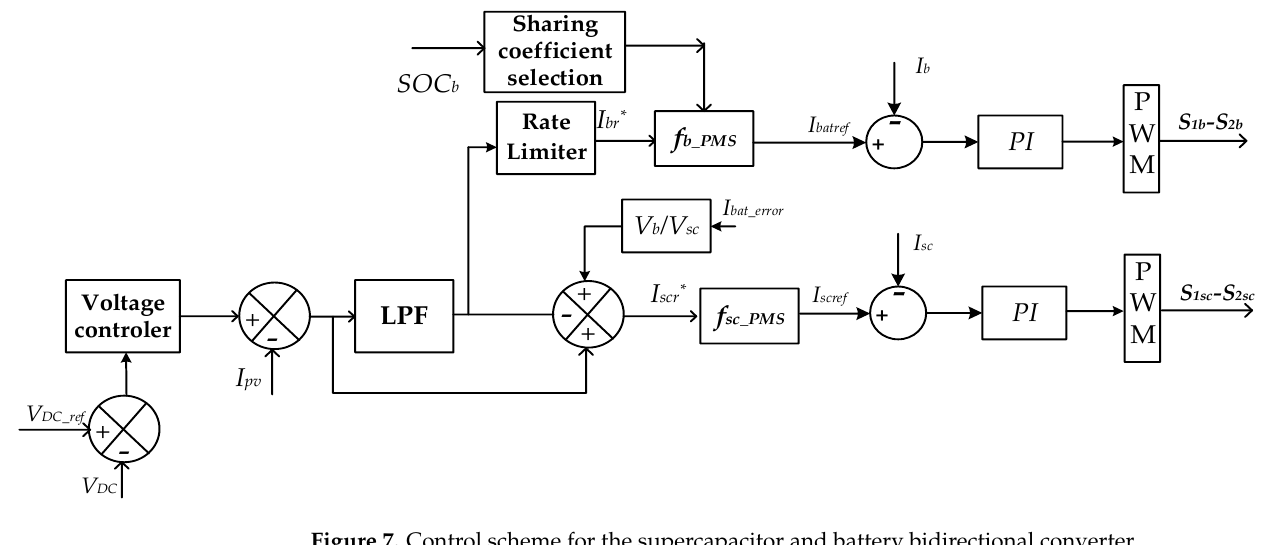
Figure 7. Control scheme for the supercapacitor and battery bidirectional converter.